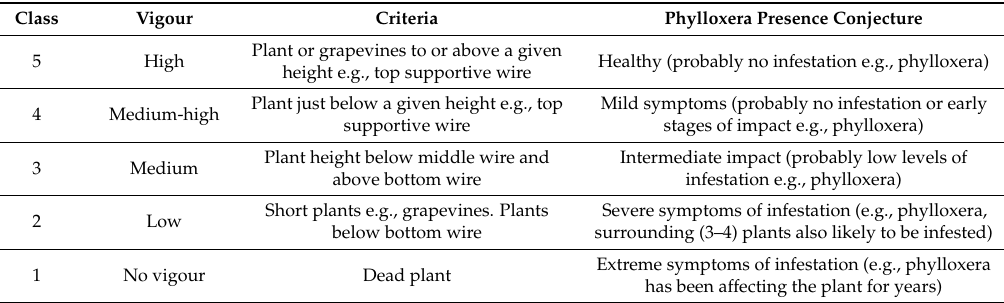
Table 2. Phylloxera vigour classes from an expert visual assessment.